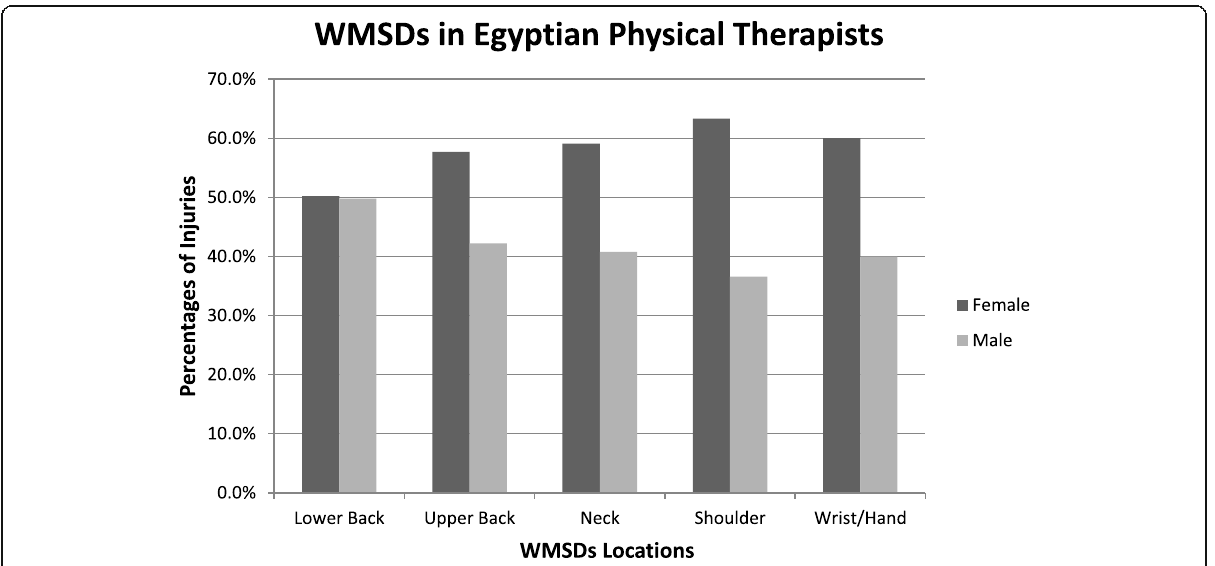
Fig. 4 Prevalence of WMSDs in participating male and female therapists